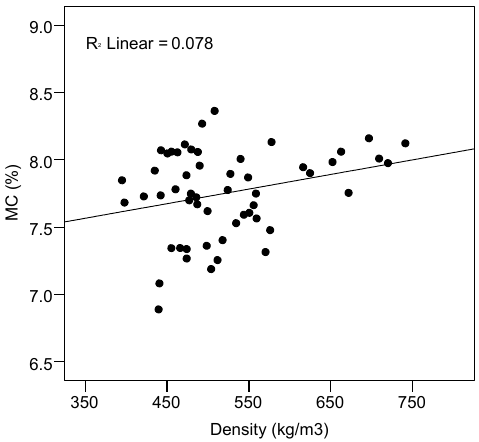
Figure 3. Variation in moisture content and density of E. nitens samples.